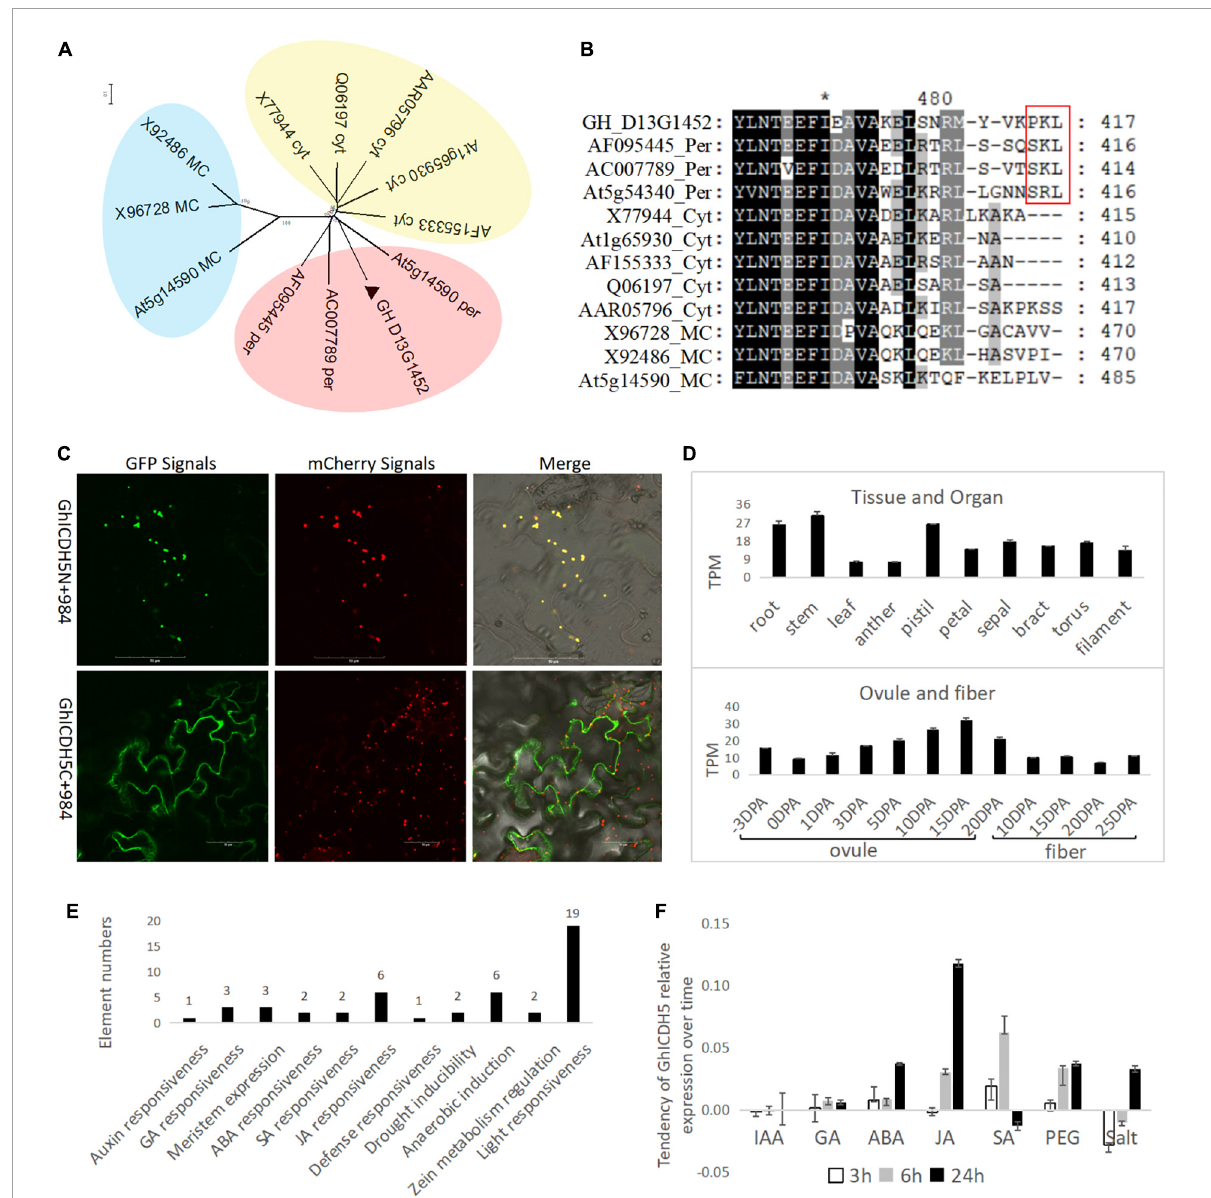
FIGURE1 Identification for a perICDH in upland cotton. (A) Phylogenetic analysis of GH_D13G1452 (labeled by (cid:78) ) with ICDHs from other species (information, see Table 1 ) by the neighbor-joining method with a bootstrap replication of 500 based on amino acid sequences. All of proteins could be divided into three groups labeled by different colors. The peroxisomal ICDH group was filled with red; the cytoplastic ICDH group, yellow; the mitochondrion/chloroplast ICDH group, blue. (B) Sequence comparison of the putative ICDHs from different species. The type-I peroxisomal targeting signal (PTS1) in C terminus of peroxisomal proteins (labeled by the red box). Per, peroxisome; Cyt, cytoplasm; MC, Mitochondrion/chloroplast. (C) Subcellular localization. ICDHs fused with GFP at their C/N-terminus transiently co-expressed with the peroxisomal marker fused with mCherry in epidermal cells of tobacco. Nine hundred eighty-four, a peroxisome localization marker fused with mCherry. C, C-terminus-fused GFP; N, N-terminus-fused GFP. Scale bar = 50 µ m. (D) Gene expression in different organs and at different stages of ovule and fiber development. DPA, day post-anthesis. (E) Cis -elements related to environmental response in the promoter of GH_D13G1452 . (F) The response of GH_D13G1452 to different abiotic